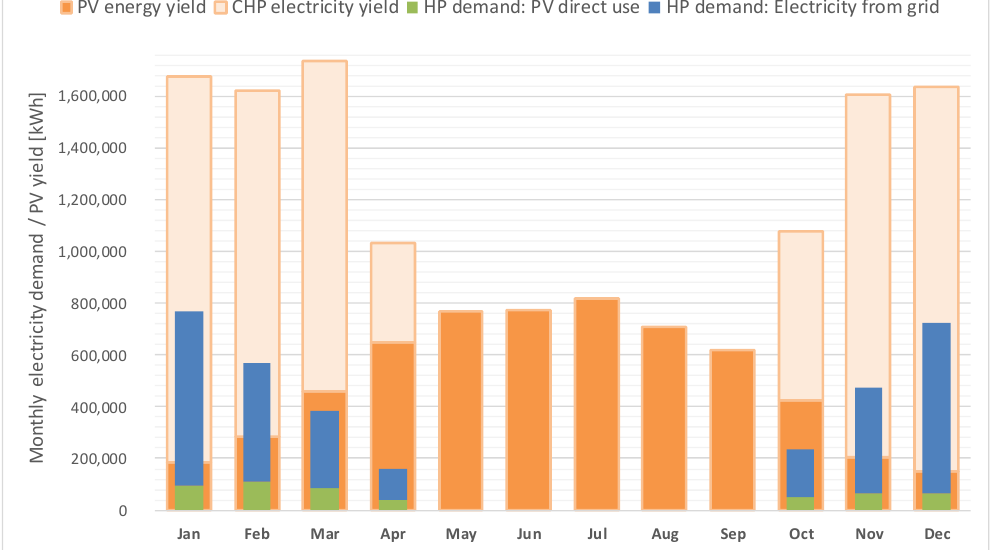
Figure 12. Monthly PV and CHP electricity yield and HP electricity demand.